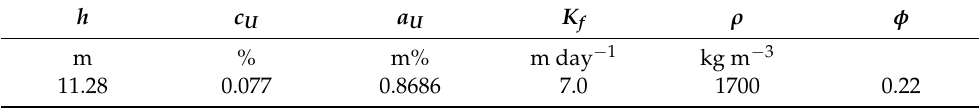
Table 11. Characteristics of the deposit block (see Figures 14 and 16).